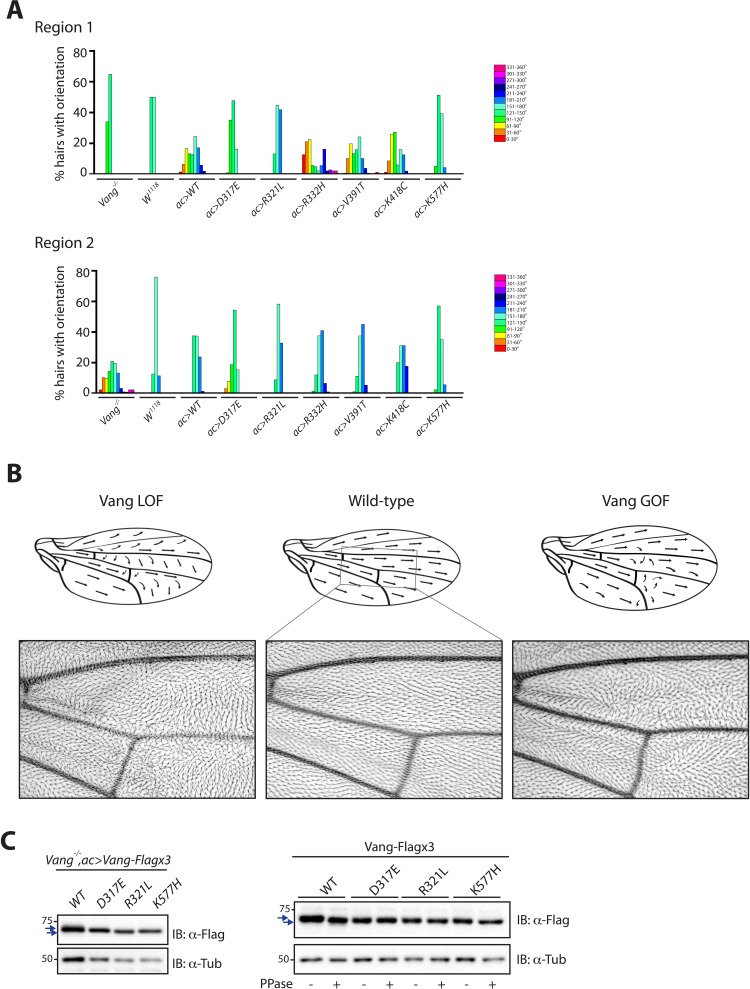
Expression of Vang transgenes mimics features of Vang gain- and loss-of-function phenotypes.(A) Graphs showing the percentage of hairs in each 30 degree segment within region 1 (above) and region 2 (below) after overexpression of wild-type Vang, Vang carrying the different mutations, or in control wings (color scheme as in Figure 2). (B) Schematic representation of changes to hair orientation in indicated conditions. Representative image of a ROI (region of interest) within an adult wing is shown next to the schematic. (C) Western blot showing changes to Vang mobility after introduction of the indicated mutations and after phosphatase treatment where indicated, arrows highlight differences. Samples were extracted from wing discs of the indicated genotypes (left) or after S2 cell transfection (right).